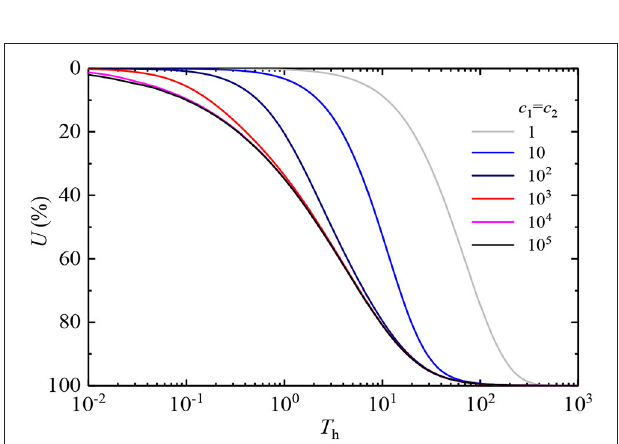
FIGURE 5 | Consolidation progress with different interface drainage parameters.